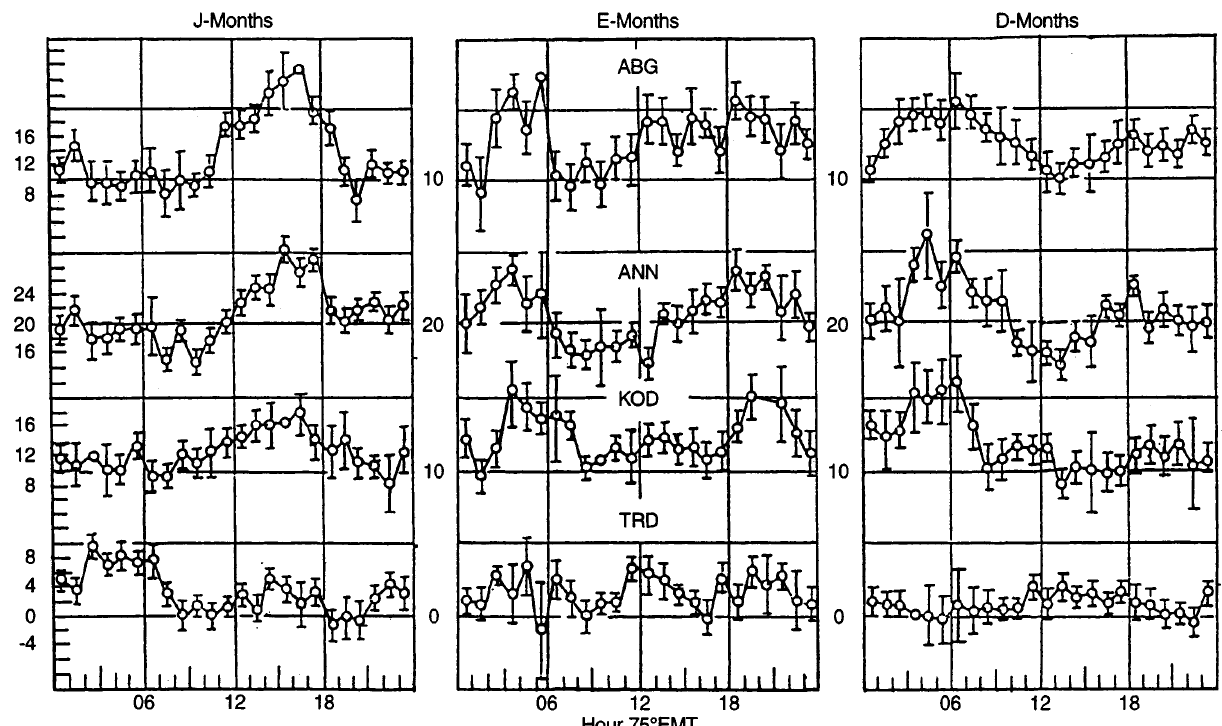
Fig. 13. Local time variations of the direction of SSC disturbance vector during di(cid:128)erent seasons of the year at each of the four Indian